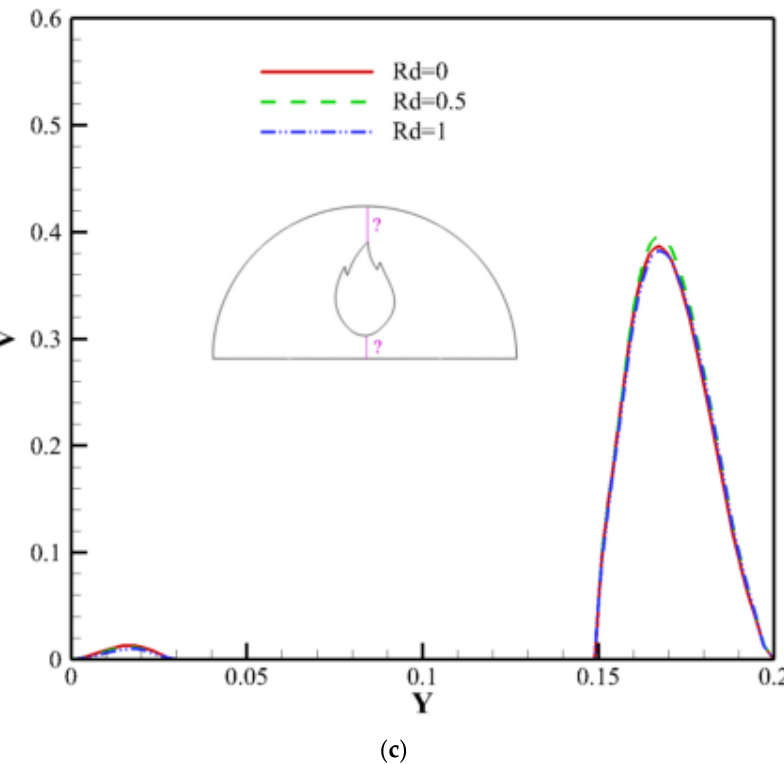
Figure 14. Variation of ( a ) Nusselt number at the enclosure heated length, ( b ) temperature along vertically mean position and ( c ) velocity alongside mean vertical location for different values of Rd at φ = 0.02, L = 0.2, Ha = 50, Da = 10 − 4 and Ra = 10 5 ).